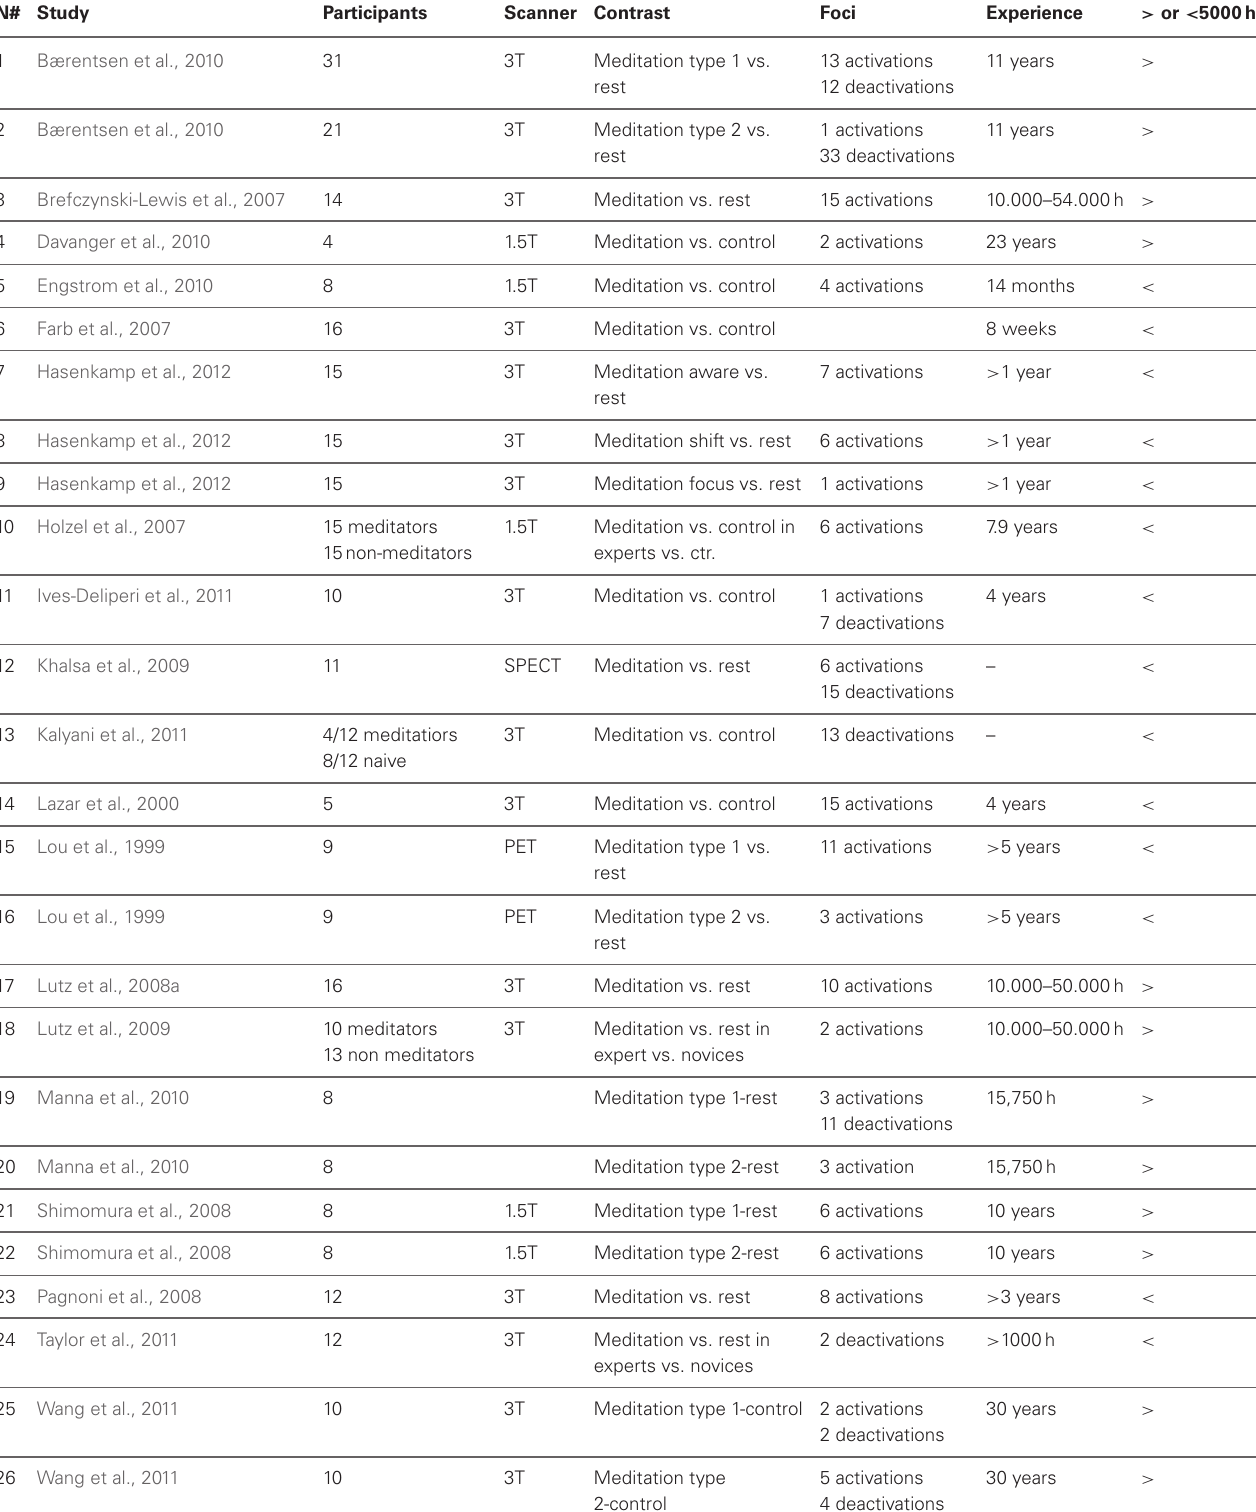
Table 1 | Publications included in the meta-analysis, task they employed, number of subjects that were investigated and number of selected foci for the ALE meta-analysis; details of years of meditation